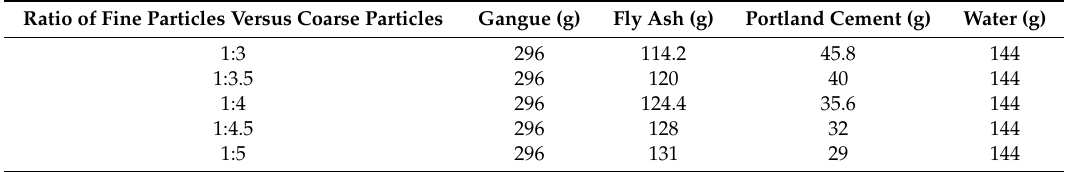
Table 8. Ratio of the slurry composition at different ratios of fly ash to cement in the slurry. Ratio of Fine Particles Versus Coarse Particles